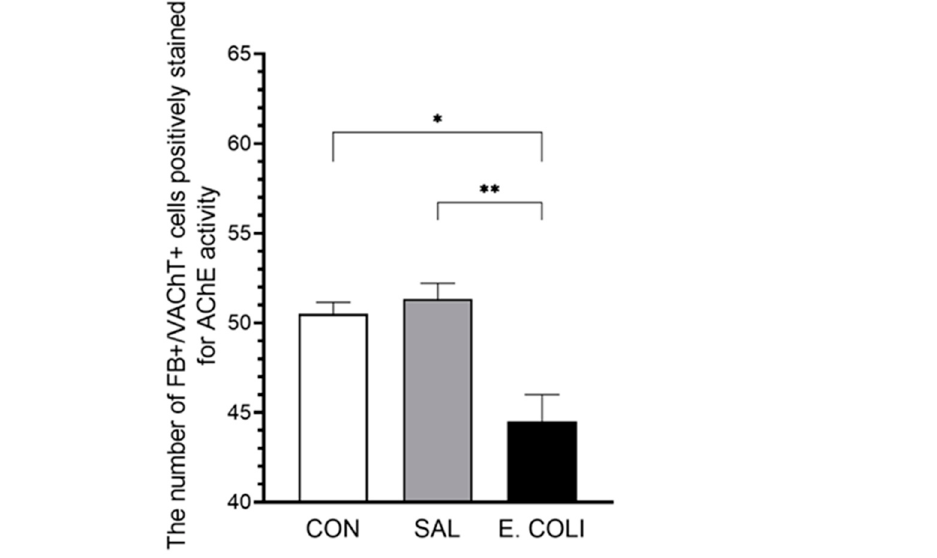
Figure 4. The numbers of both FB- and VAChT-positive neurons positively stained for AChE (mean ± SEM) in the PCG counted in the gilts from control (CON), saline (SAL), and E . coli ( E . coli ) groups (* p < 0.05 and ** p < 0.01 show the differences between groups).